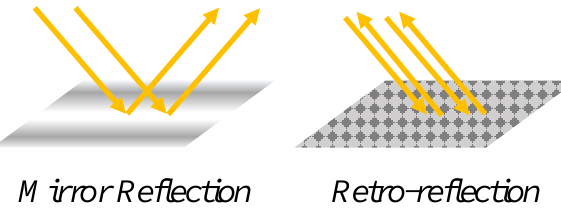
Figure 2. Mirror Reflection vs.